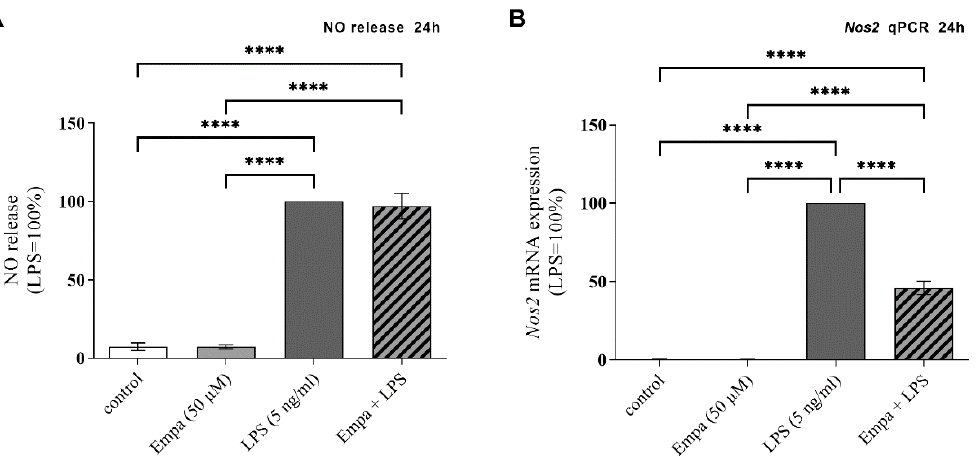
Figure 2. LPS significantly increased NO release ( A ) and Nos2 mRNA expression ( B ) in primary microglia. Treatment with 50 µM empagliflozin showed no influence on NO release ( A ), while LPS-induced Nos2 mRNA expression was significantly decreased after 24 h ( B ) (asterisks indicate all significant differences; **** p ≤ 0.0001; one-way ANOVA, followed by Tukey test; F-value = 1797 ( A ), 1438 ( B ); n ≥